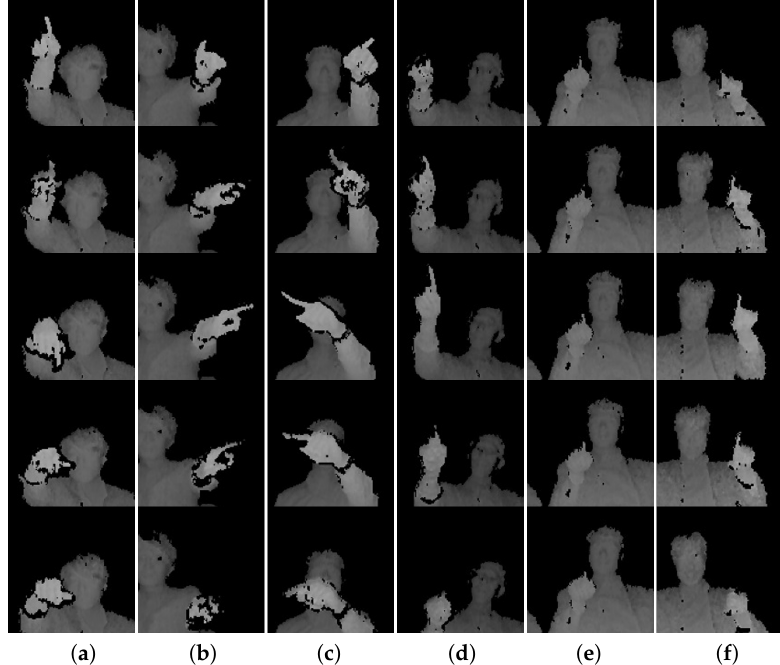
Figure 6. Example of the six gestures of our dataset. The temporal order of each gesture progresses from the top to bottom rows. ( a ) Flicking-down, ( b ) flicking-left, ( c ) flicking-right, ( d ) flicking-up, ( e ) pointing, and ( f ) pushing. Note that for better visualization, frames with zoom-in are shown. Refer to the Figure 1 for an example of raw